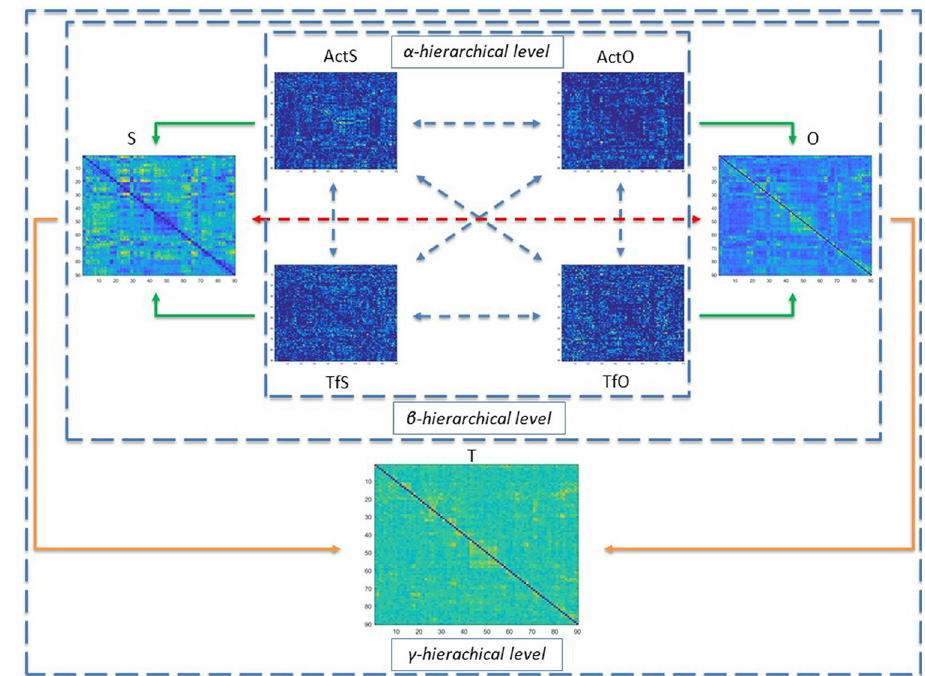
Figure 8. Schematic overview of the multiplex network defined in this paper. The four α-hierarchical level matrices (ActS, TfS, ActO and TfO) are in the central core; the β-hierarchical level matrices (S and O) on the left and the right side of the core, respectively, and the γ-hierarchical level matrix (T) on the bottom side. The interactions among single-layers of the vector of adjacency matrices at the α- and β-hierachical level, are indicated by blue and red dashed double arrow, respectively. The weighted aggregated overlapping adjacency matrices to the higher hierarchical level are indicated by green (from the α- to β-hierachical level) and orange (from the β- to γ-hierachical level) arrows.